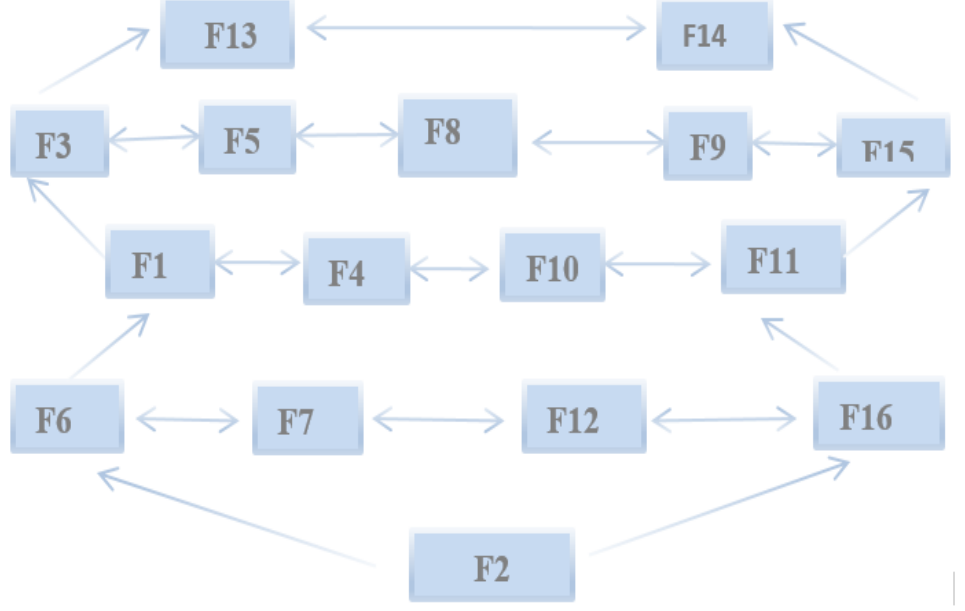
Figure 3. ISM-based model for barriers. Table 5. Driving power (DRP) and dependence power (DEP) on stabilised